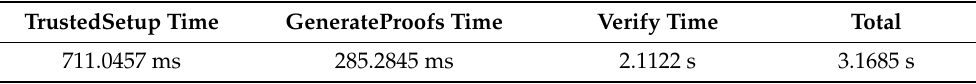
Table 4. Time consumption for trusted setup and proof generation.